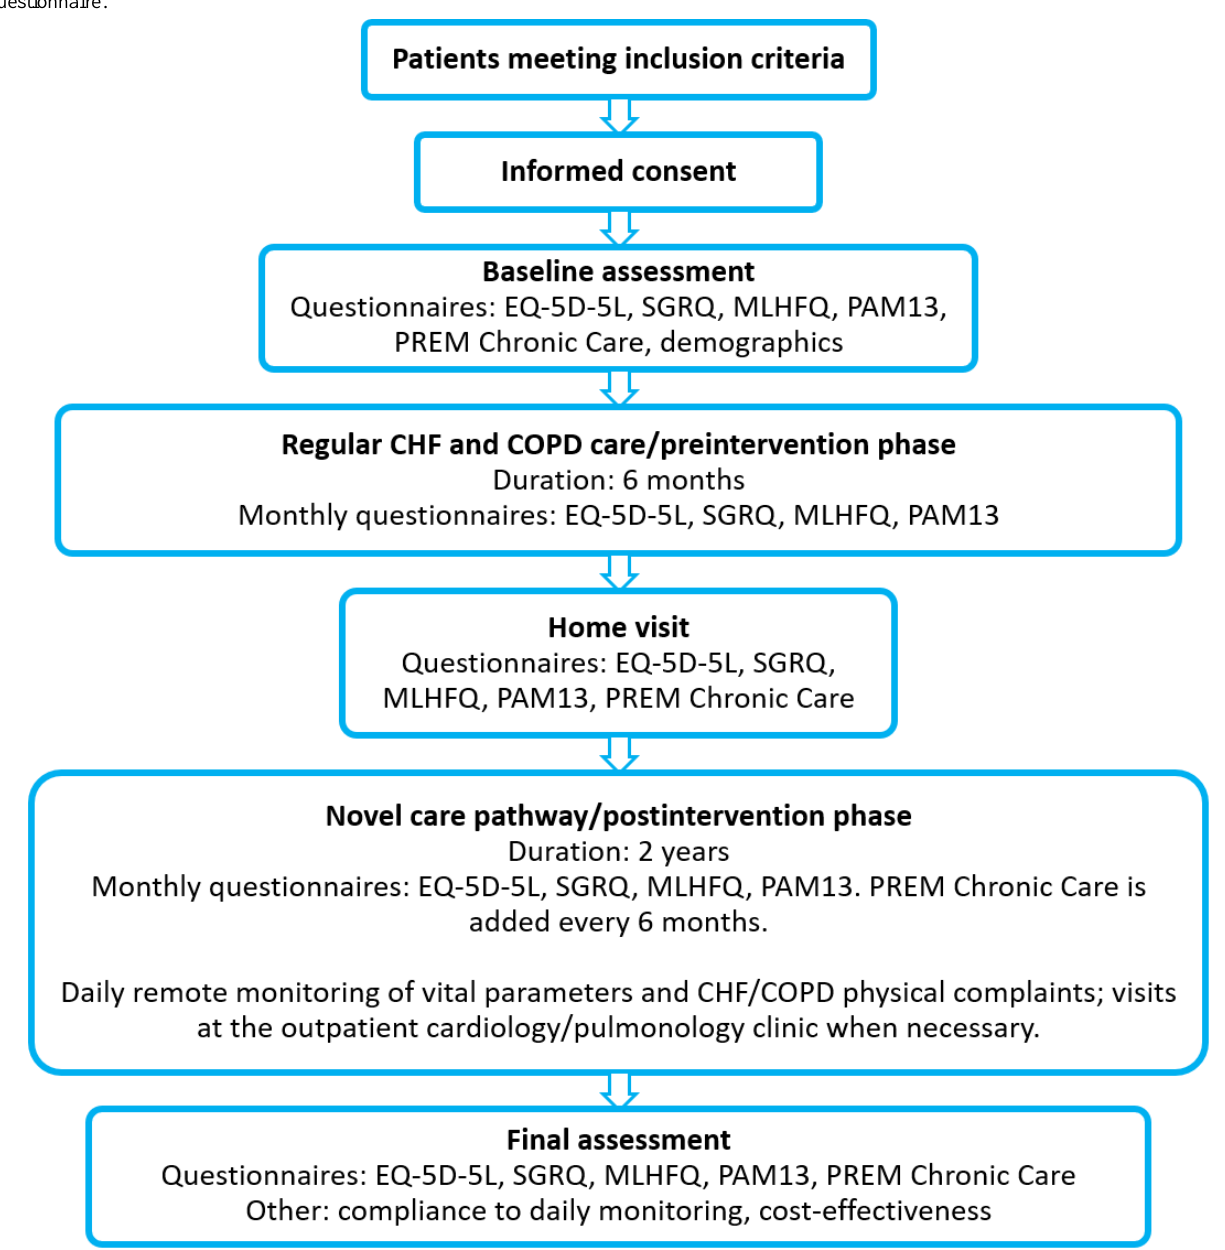
Figure 1. Flowchart of the study design. CHF: chronic heart failure; COPD: chronic obstructive pulmonary disease; MLHFQ: Minnesota Living with Heart Failure Questionnaire; PAM13: 13-item Patient Activation Measure; PREM: Patient-Reported Experience Measure; SGRQ: St George’s Respiratory